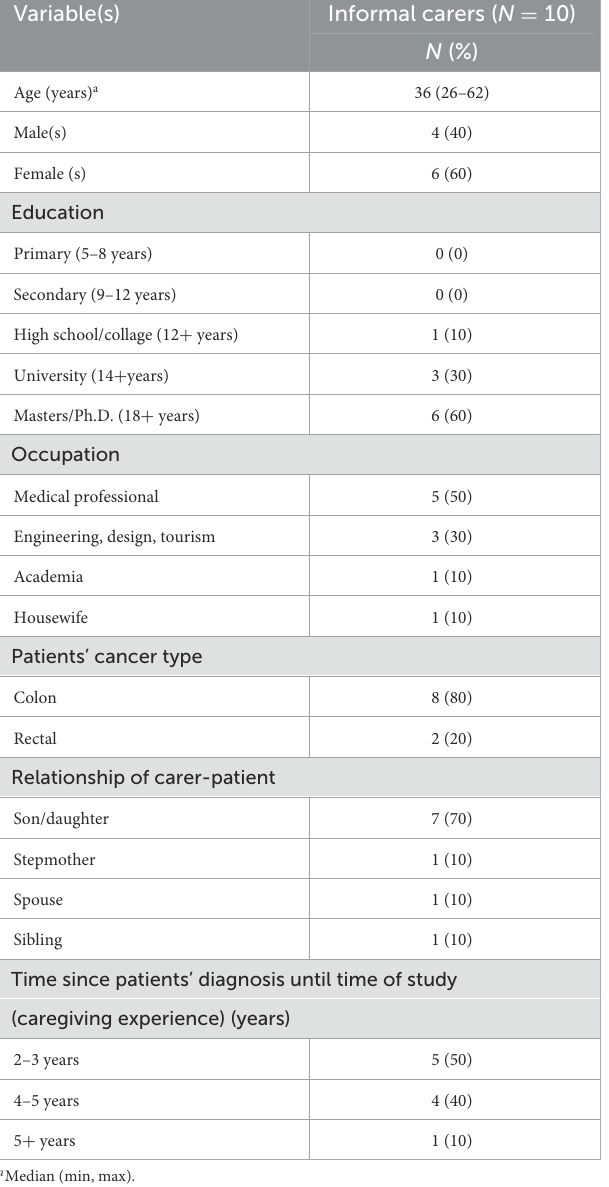
TABLE 2 Characteristics of participants of semi-structured interviews ( n = 15).